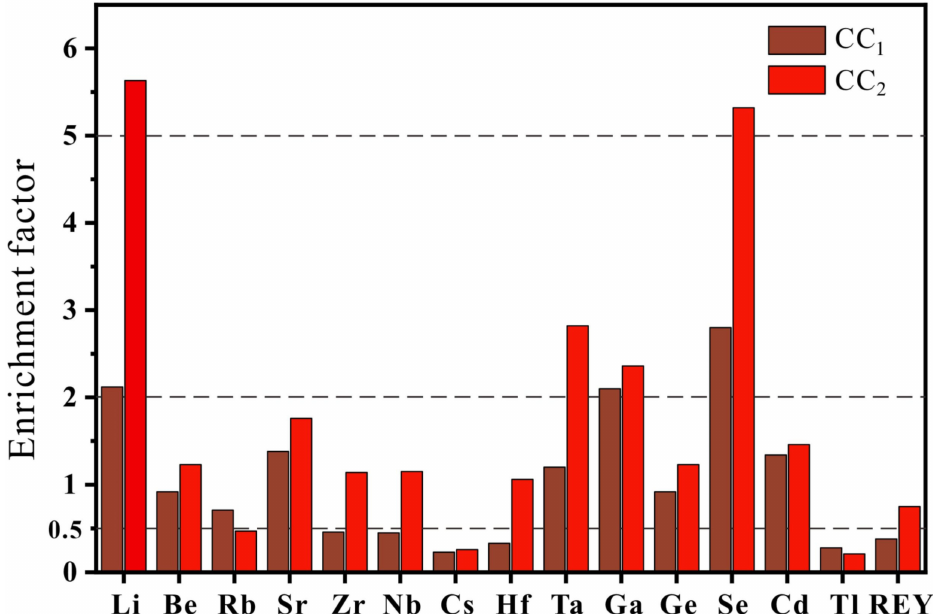
Figure 4. Ratio of the Shanxi Formation coal to Chinese coal and world coal in the Huainan coal- field. CC 1 —concentration coefficient = AM of this study/AM of Chinese coal. CC 2 —concentration coefficient = AM of this study/AM of world hard